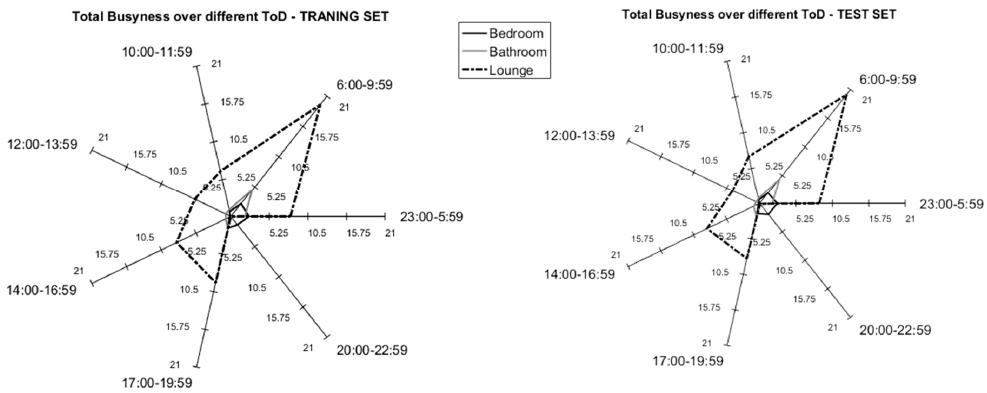
Figure 3. Example training set ( left ) and test set ( right ) comparison in terms of mean Busyness over the different Times of the Day (ToD) for U1.